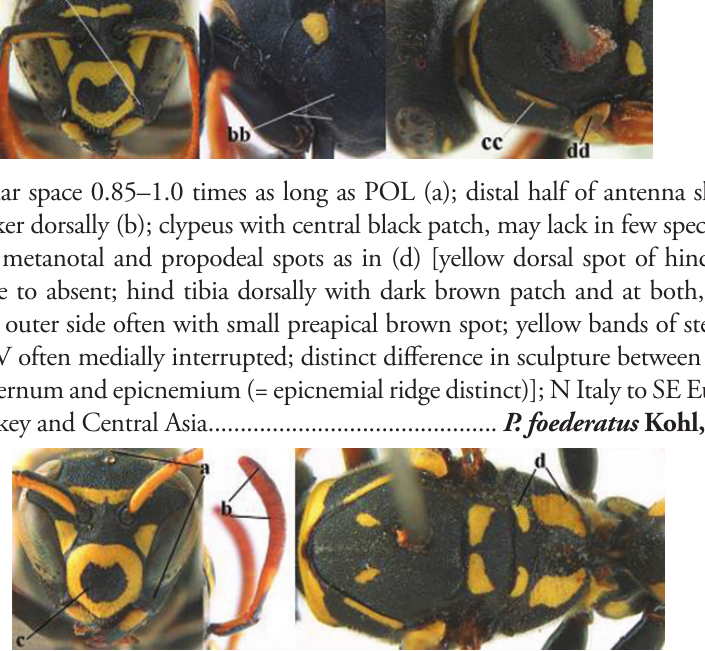
– Malar space at most 0.75 times as long as POL (aa); antenna as pale dorsally as ventrally (bb), but darker dorsally in some P. bischoffi ; central dark patch on clypeus usually smaller and situated below middle of clypeus or